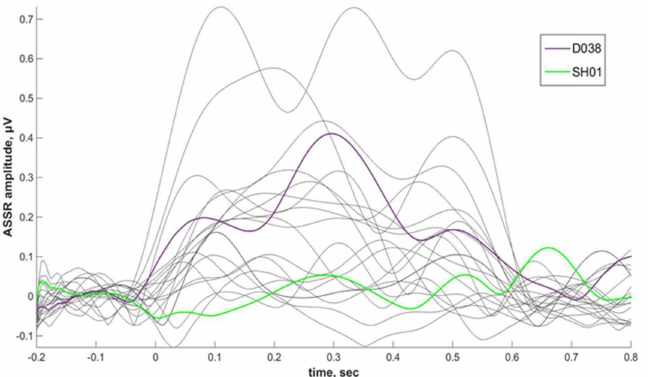
Figure A3. Comparison of ASSR values ( µ V) for the participant D038 who took phenibut (violet) and the participant SH01 (green). Individual amplitudes of ‘young’ group are shown in grey. The time of stimulus presentation is 0.